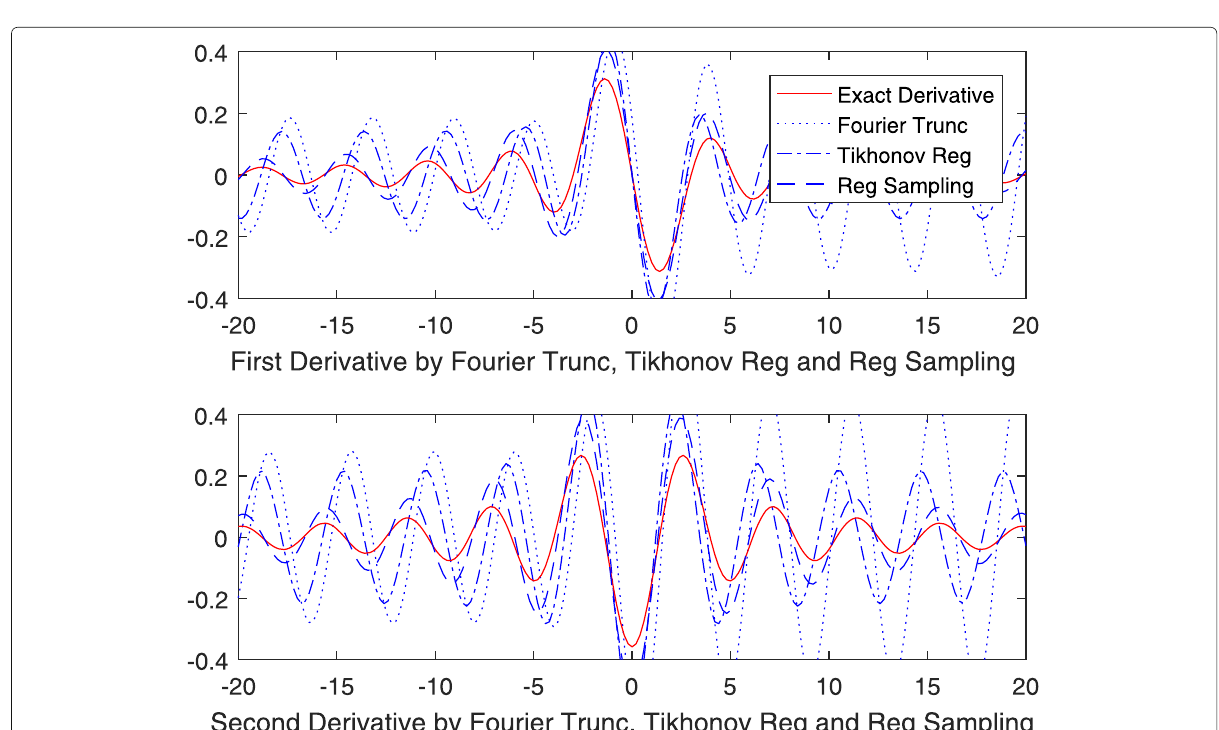
Fig. 1 The simulation results for the bipolar δ noise in Example